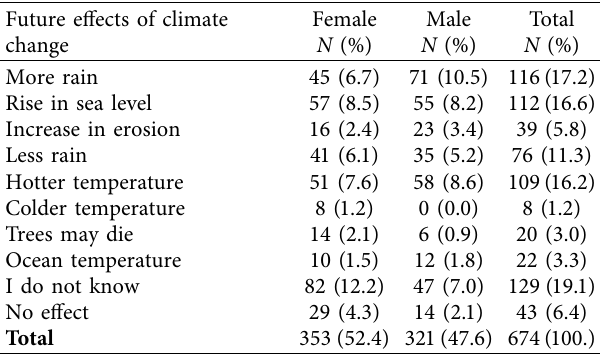
Table 4: Respondents’ perception of the future effects of climate in